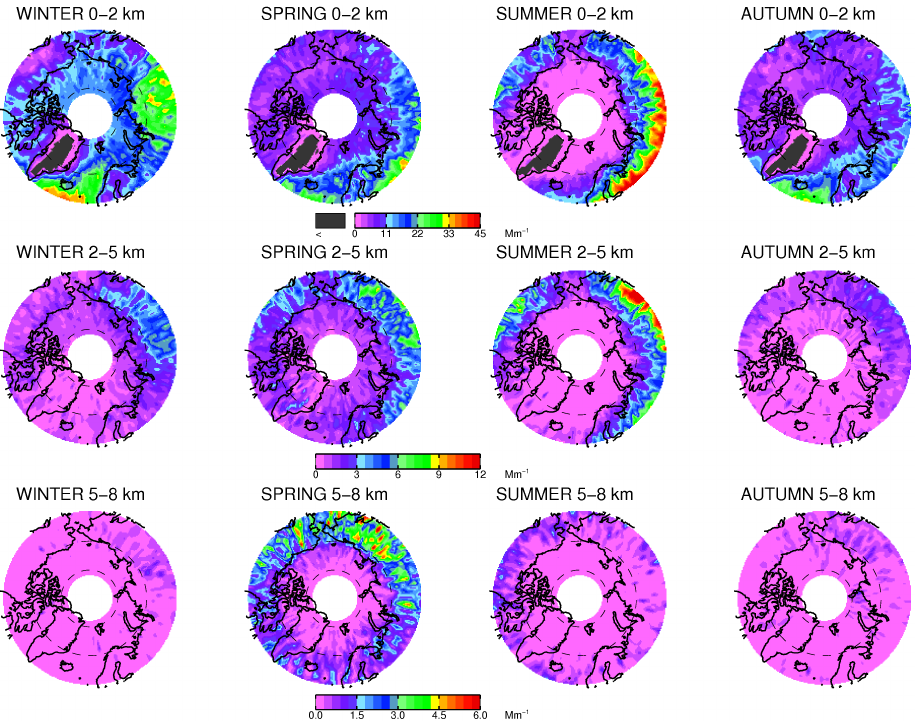
Fig. 10. Spatial distribution of the 2006–2012 seasonal mean CALIOP nighttime-equivalent extinction. Maps are shown at 0–2km (top panels), 2–5km (middle panels) and 5–8km (bottom panels) for winter (DJF), spring (MAM), summer (JJA) and autumn (SON). Note that the color scale saturation values are lowered at higher altitudes. Dashed lines mark the 70 ◦ N and 80 ◦ N latitude